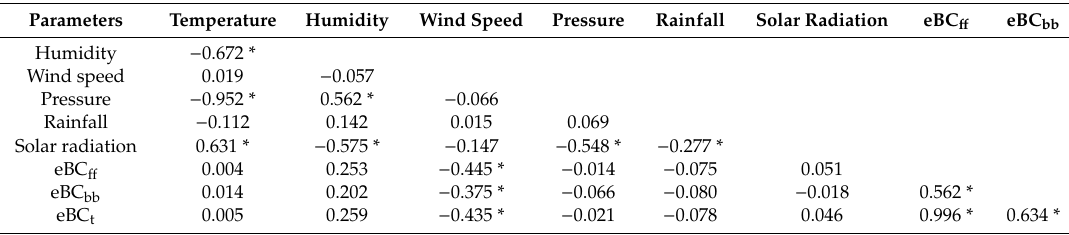
Table 2. Statistical correlations between black carbon fractions and meteorological parameters.